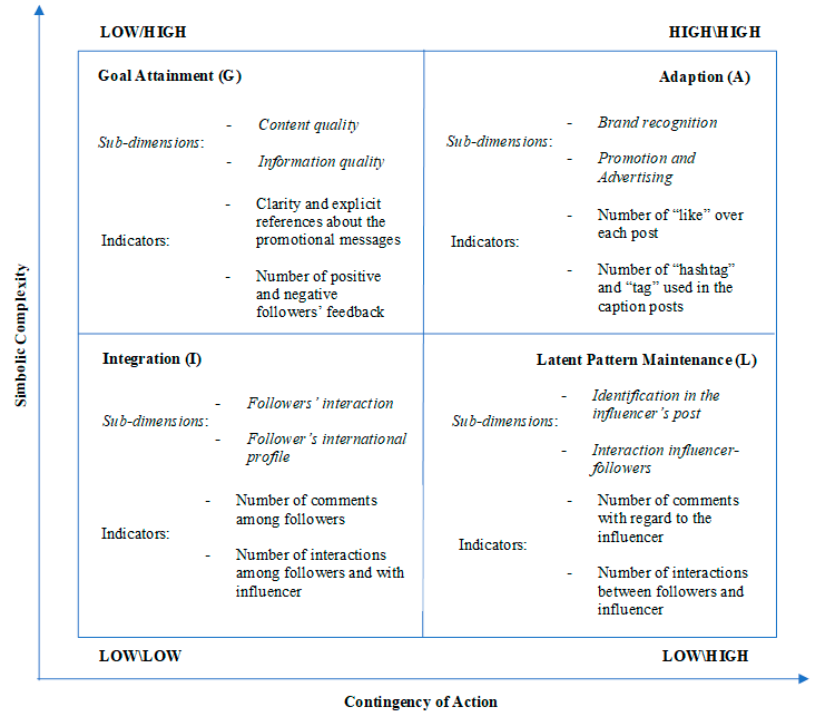
Figure 2. Authors’ presentation of the AGIL scheme with indicators observed in the IG profile of Chiara Ferragni by the netnographic analysis. Chiara Ferragni by the netnographic